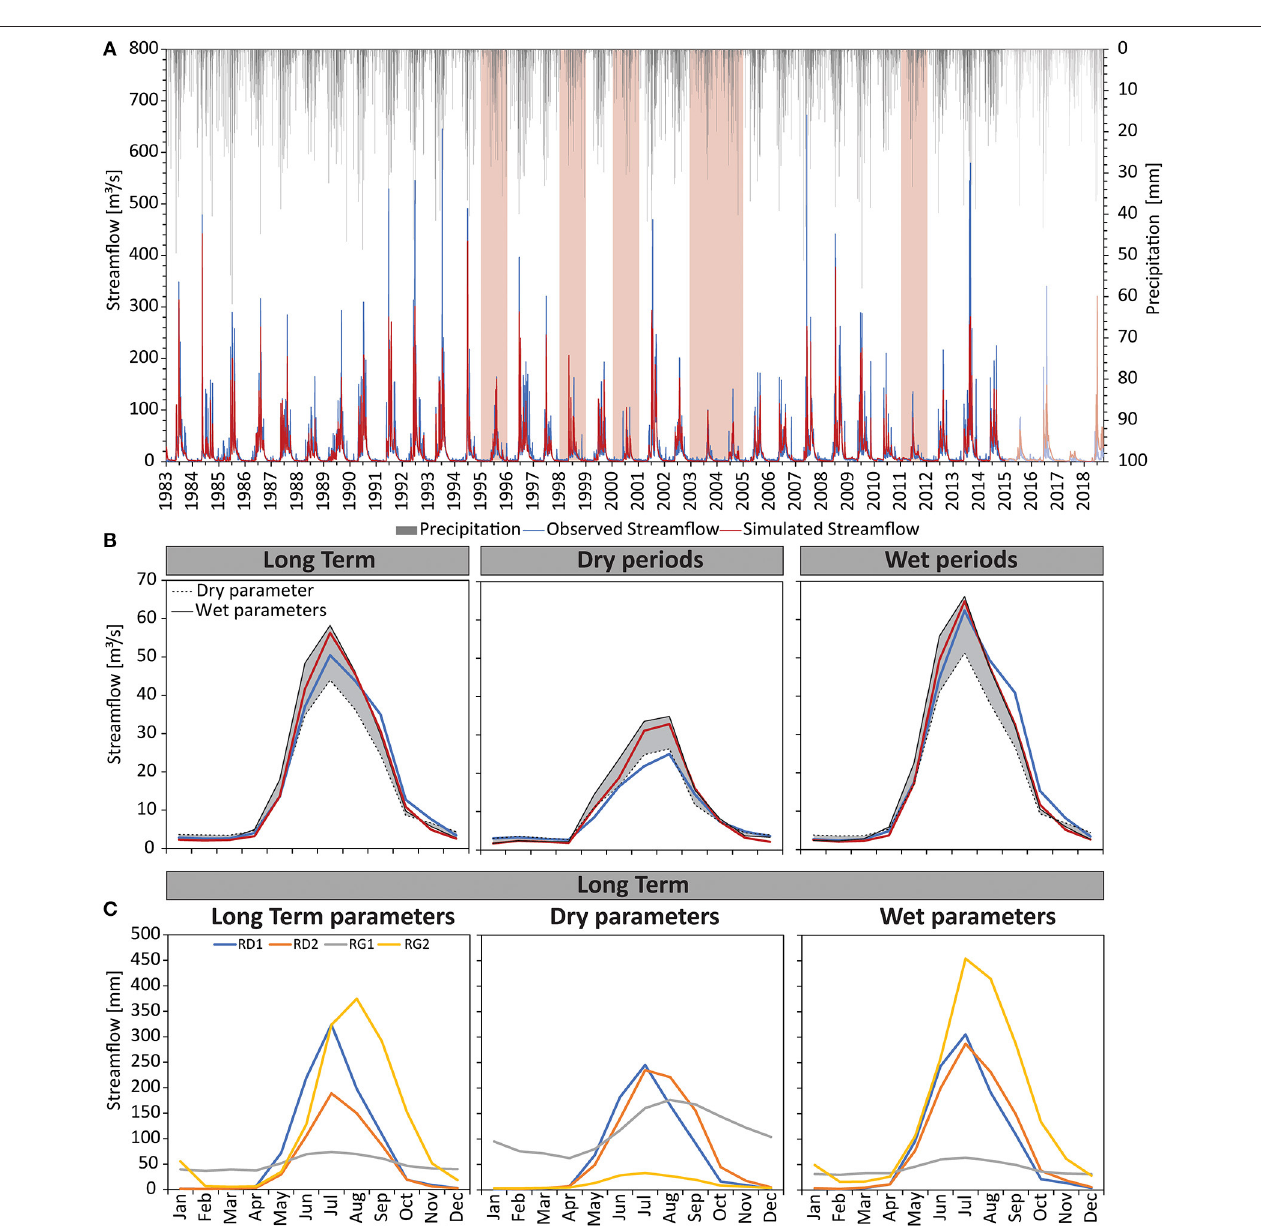
FIGURE 5 | (A) The long-term (1984–2018) time series of the simulated (red line) and observed streamflow (blue line) with precipitation (gray bar) and the identified dry periods (1995, 1998, 2000, 2003–2004, and 2011) (pink bar). (B) The simulated monthly hydrograph for the long term timeseries, dry and wet periods using θ long − term , θ dry and θ wet where the dry (dashed line) and wet (black line) parameters form the upper and lower simulation limits (grayed area). (C) The difference between the simulated hydrological flow components using θ long − term , θ dry and θ wet where RD1 was surface runoff (blue line), RD2 was interflow (orange line), RG1 was fast groundwater flow (gray line) and RG2 was slow groundwater flow (yellow line). θ long − term and θ wet had a similar flow component breakdown with a dominance of surface runoff and slow groundwater flow, unlike θ dry where the flow components were more equally split between surface runoff and interflow with fast groundwater the next most